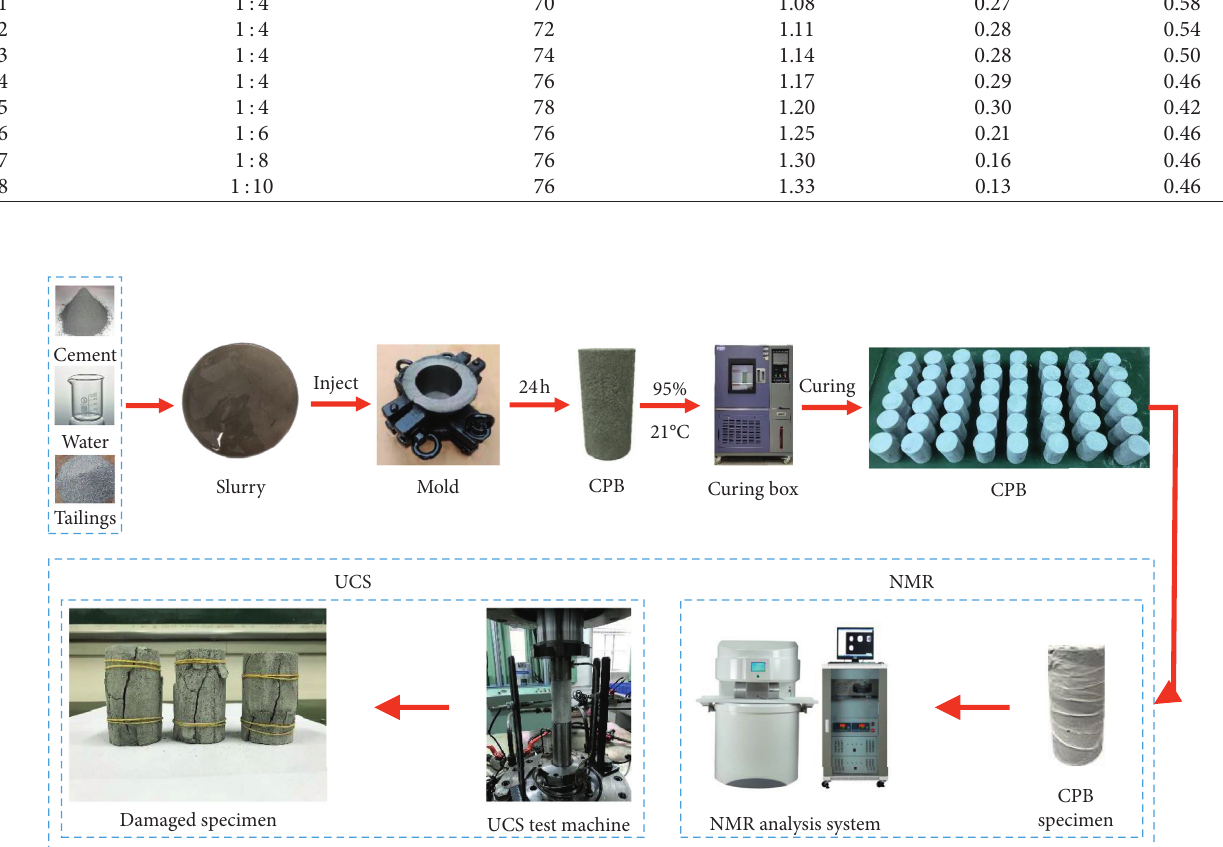
Figure 3: Experimental flow picture.